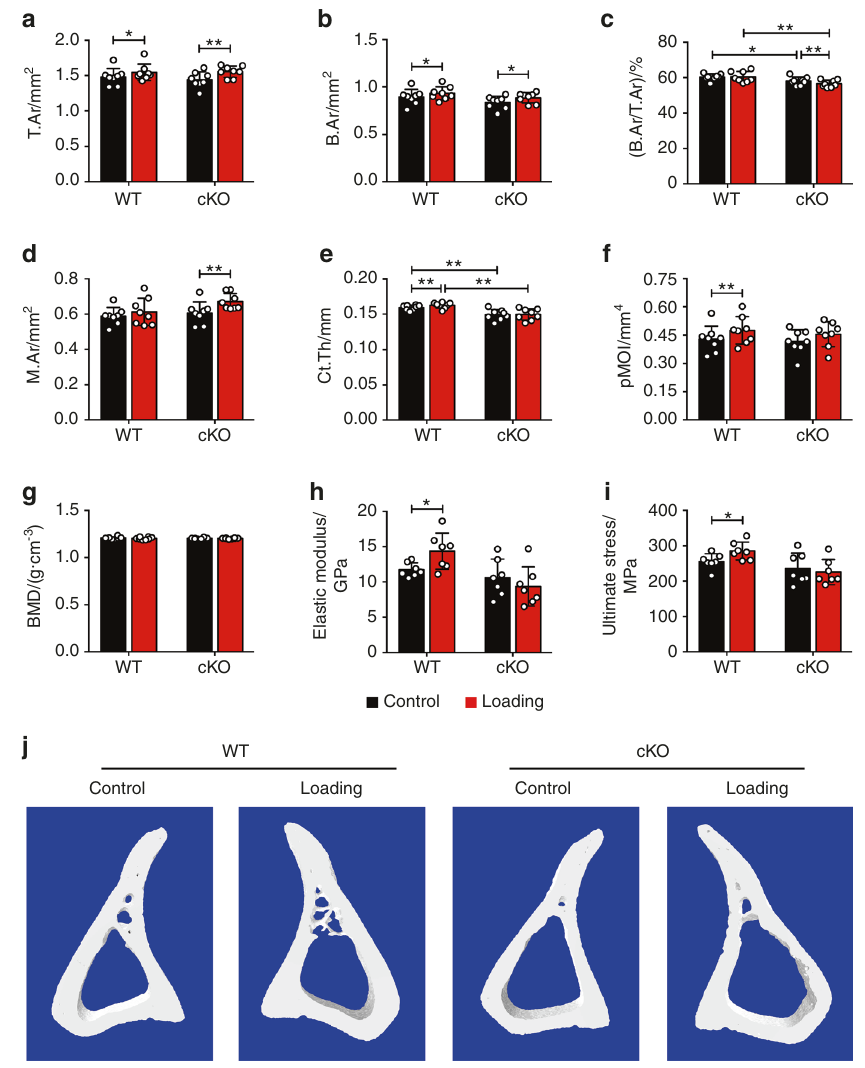
Fig. 3 Deletion of integrin α 5 in osteocytes attenuated or reversed the anabolic function of mechanical loading in midshaft cortical bone. μ CT analysis of the mid-diaphyseal region located 37% from the proximal end, for both loaded and contralateral, unloaded tibias of WT and cKO mice: a total cross-sectional area (T.Ar), b bone area (B.Ar), c bone area fraction (B.Ar/T.Ar), d bone marrow area (M.Ar), e cortical thickness (Ct.Th), f polar moment of inertia (pMOI), and g bone mineral density (BMD). n = 8 per group. j Representative 3D models of the cortical bone for WT and cKO mice. Three-point bending test was performed for tibias bones of WT and cKO mice: h elastic modulus and i ultimate stress. n = 7 per group. Mean ± SD. * P < 0.05; ** P < 0.01. Paired t test was used for loaded and contralateral tibias and unpaired t test for loaded or control tibias between WT and cKO loading increased EB uptake of osteocytes in WT mice, but not in cKO mice (Fig. 6a). The quanti fi cation of EB fl uorescence intensity con fi rmed the inhibited dye uptake in cKO mice (Fig. 6b, c). Similarly,